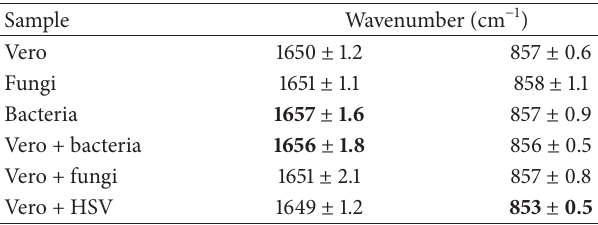
Table 1: Changes in peaks position at 857 and 1650cm − 1 as a result of Vero cells infection with HSV-1 or contamination with E. coli or fungi.